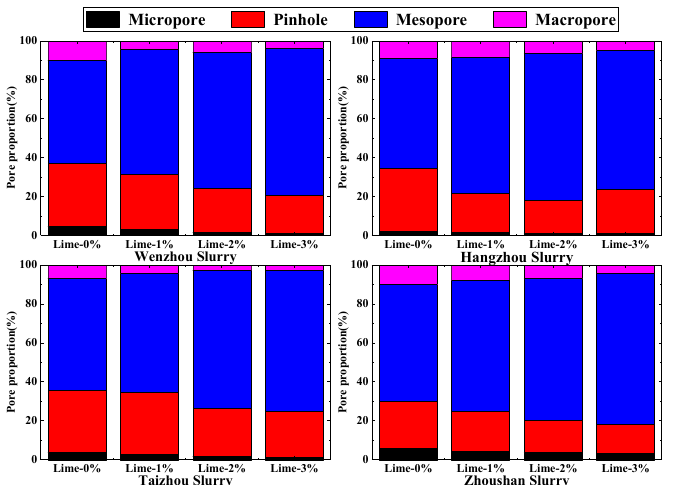
Figure 8. Pore classification results of stabilized soil samples for each group with different lime dosages.